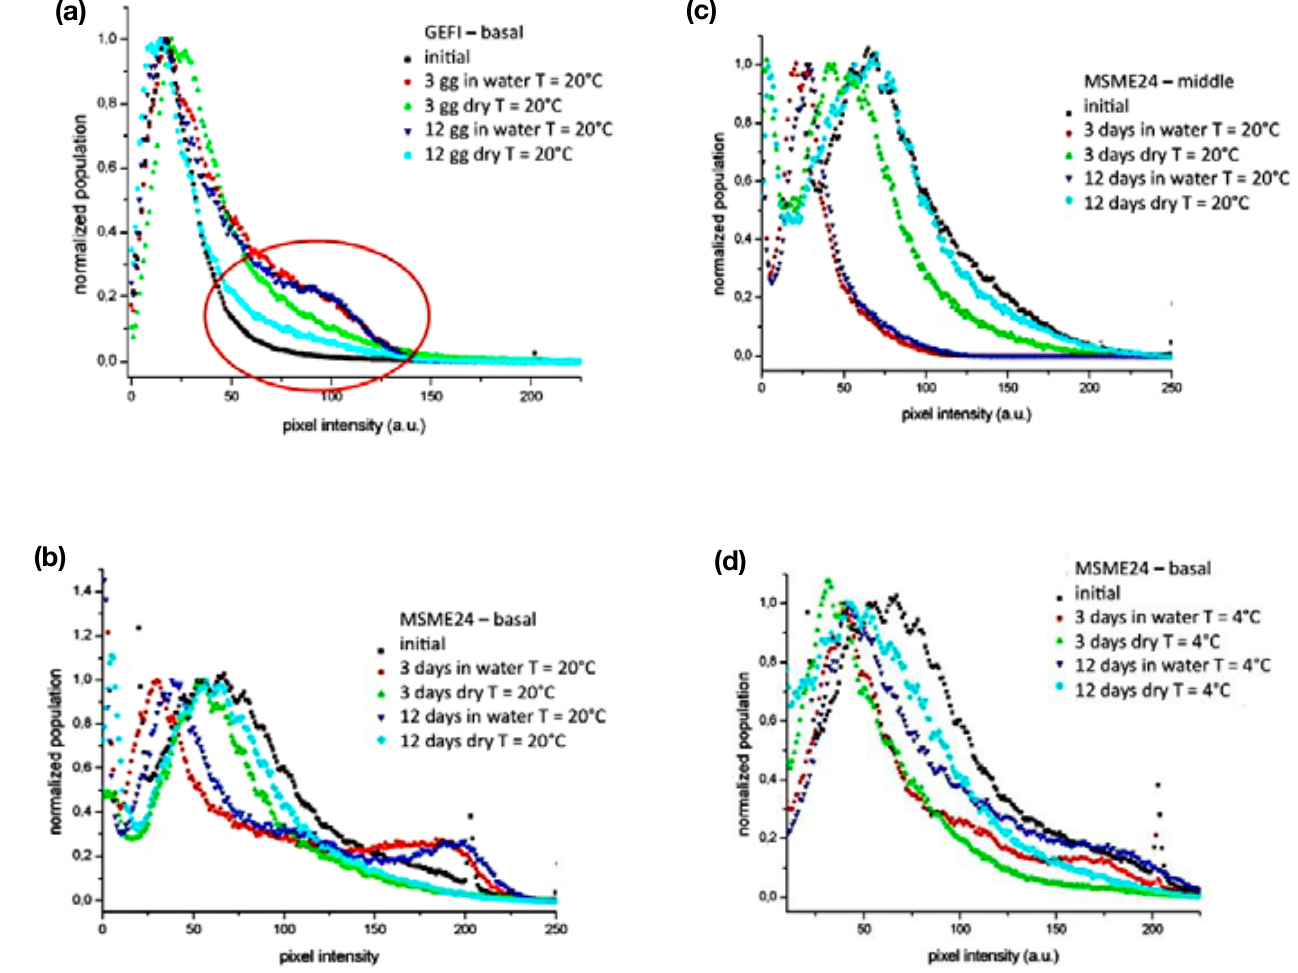
Fig. 3 - Normalized population vs pixels (a.u. = auxiliary units) elaboration of GEFI (3a) and MSME (3b,c,d)